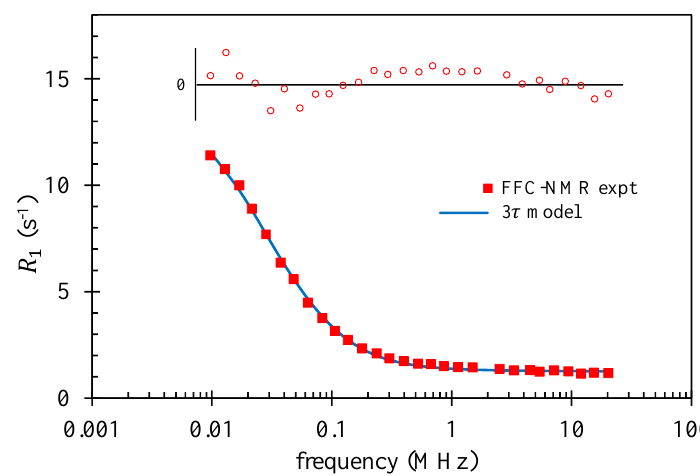
Figure 4. FFC-NMR spin–lattice relaxation rate data for a plaster paste by Korb [5], presented as a function of frequency. The solid curve represents the best fit obtained using the 3 τ model and the 3TM fitting package. The open circles represent the residuals with the horizontal line indicating a residual of